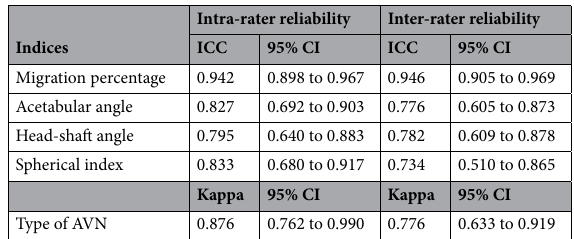
Table 2. Intra-rater and inter-rater reliabilities of the radiographic indices. ICC intraclass correlation coefficient, CI confidence interval, AVN avascular necrosis of the femoral head.